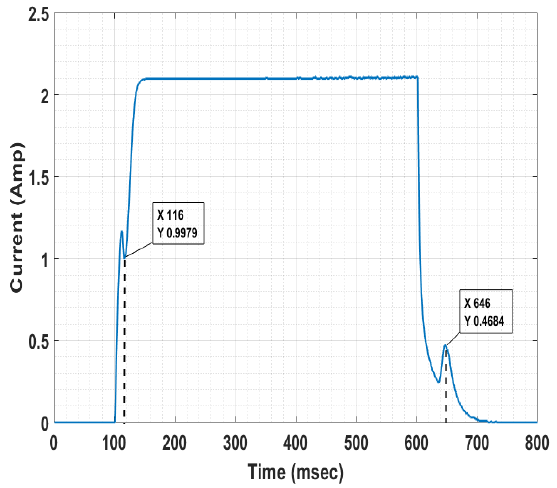
Figure 8. Solenoid valve passing current after it has excited by a pulse signal of amplitude 24 volt and frequency 2